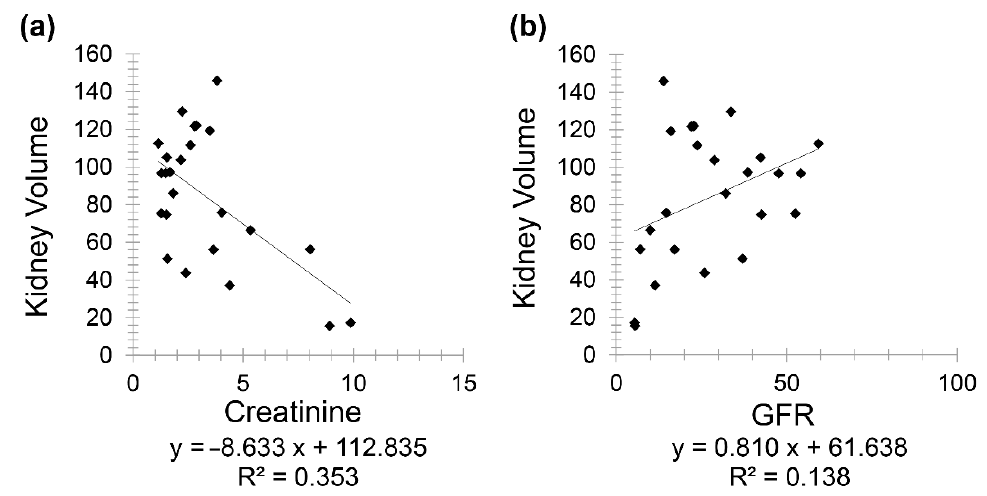
Figure 4. Scatter plot graphs showing ( a ) negative correlation between kidney volume and creatinine ( r = − 0.594) and ( b ) positive correlation between kidney volume and GFR ( r = 0.371) in CKD patients. Patients having both CKD and diabetes (Group 4) included 31 patients (19 females and 12 males) with a mean age of 75.21 for females (minimum 61 and maximum 86) and a mean age of 72.08 for males (minimum 59 and maximum 86). A negative correlation was found between GFR and HbA1C ( r = − 0.031) and a positive correlation between creatinine and HbA1C ( r = 0.118) (Figure 5). Interestingly, a positive correlation was observed between kidney volume and HbA1C ( r = 0.178).